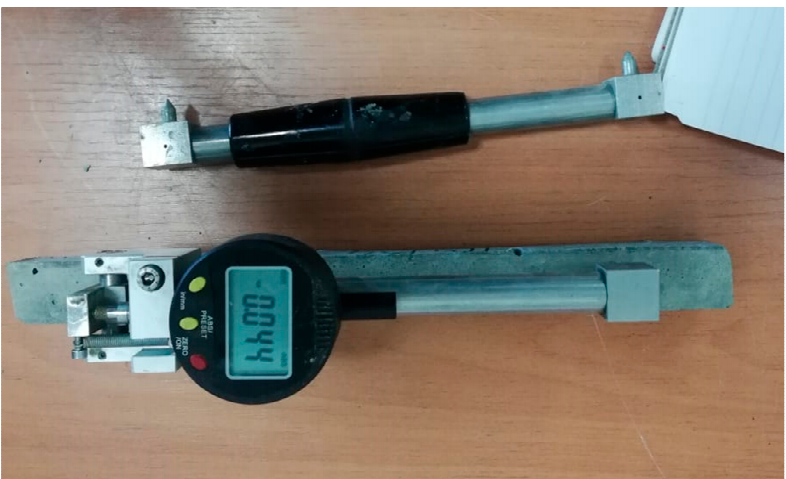
Figure 4. Mechanical strain gauge.